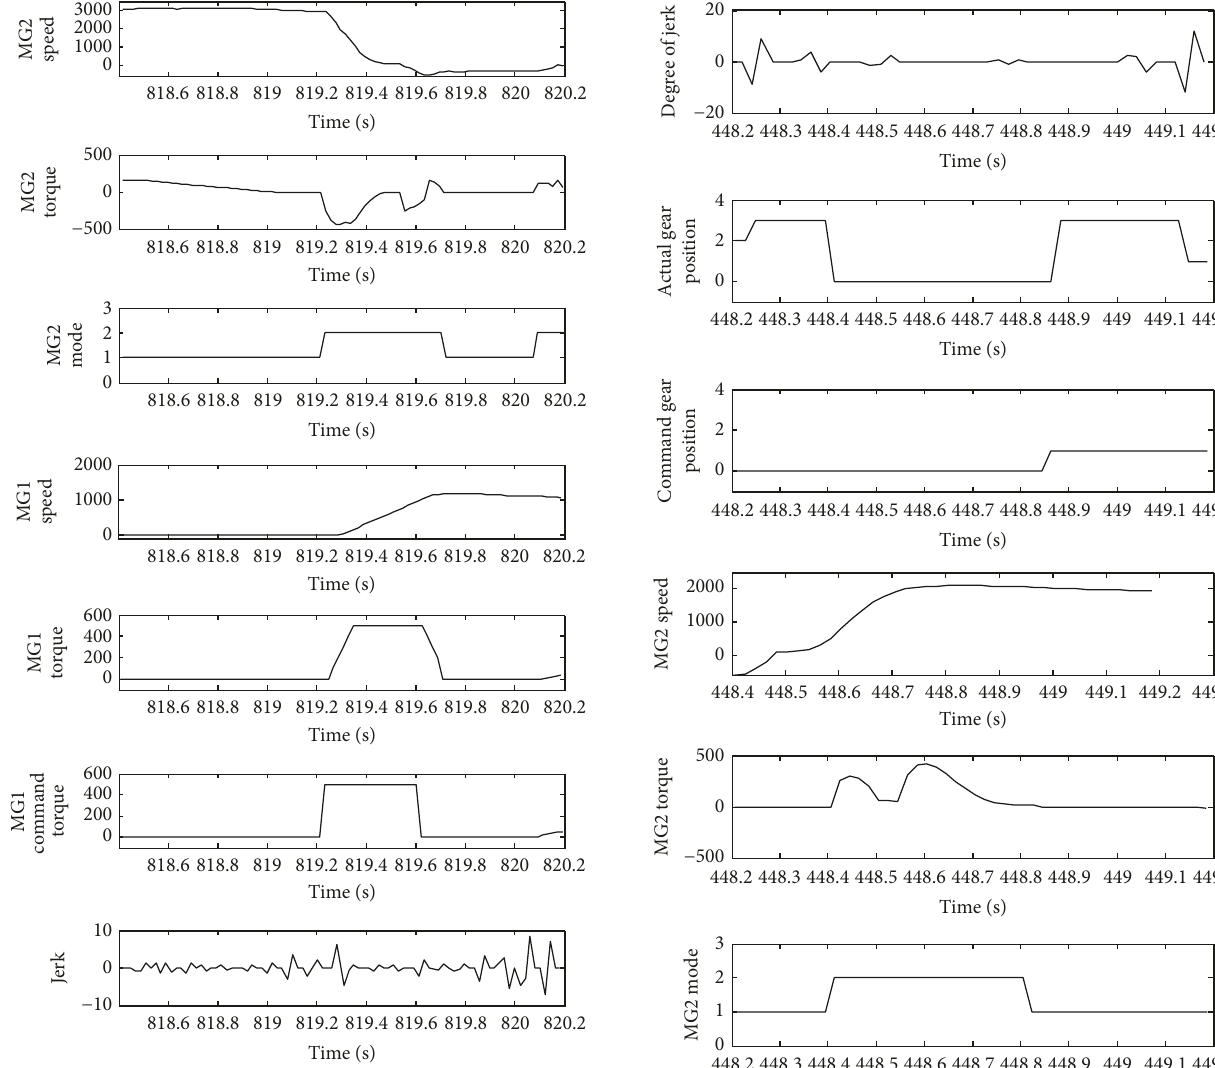
degree of jerk is 8.42 m/s 3 , which is smaller than Chinese standard (𝐽 < 17.64 m / s 3 ) . So the comfort requirements are met during the upshift